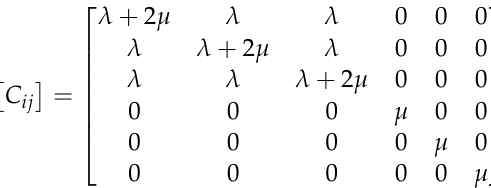
Table 3. Elastic stiffness constants of the cellulose amorphous region for different pressures. Pressure